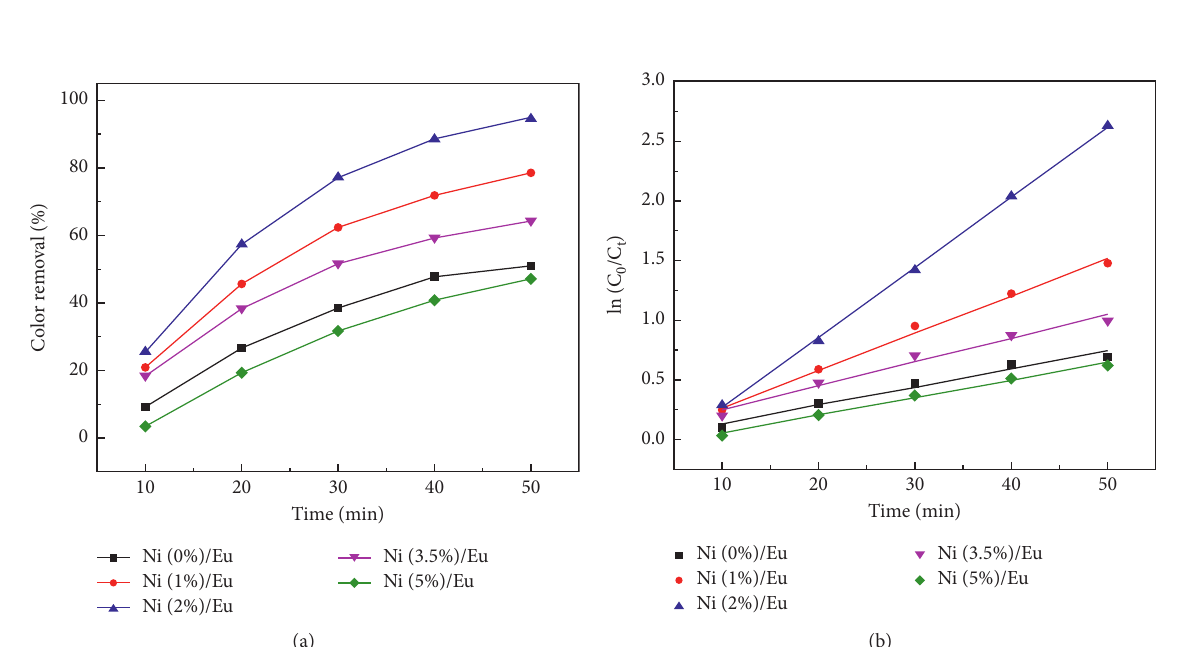
Figure 12: Electrochemical decolorization performance at Ti/SnO 2 -Sb-Ni/Eu electrodes modified with various Ni contents. (a) Decol- orization efficiency. (b) Kinetic analysis of the curves (RhB concentration: 40mg · L − 1 ; current density: 10mA · cm − 2 ; supporting electrolyte: 0.1mol · L − 1 Na 2 SO 4 ; 25 ° C).